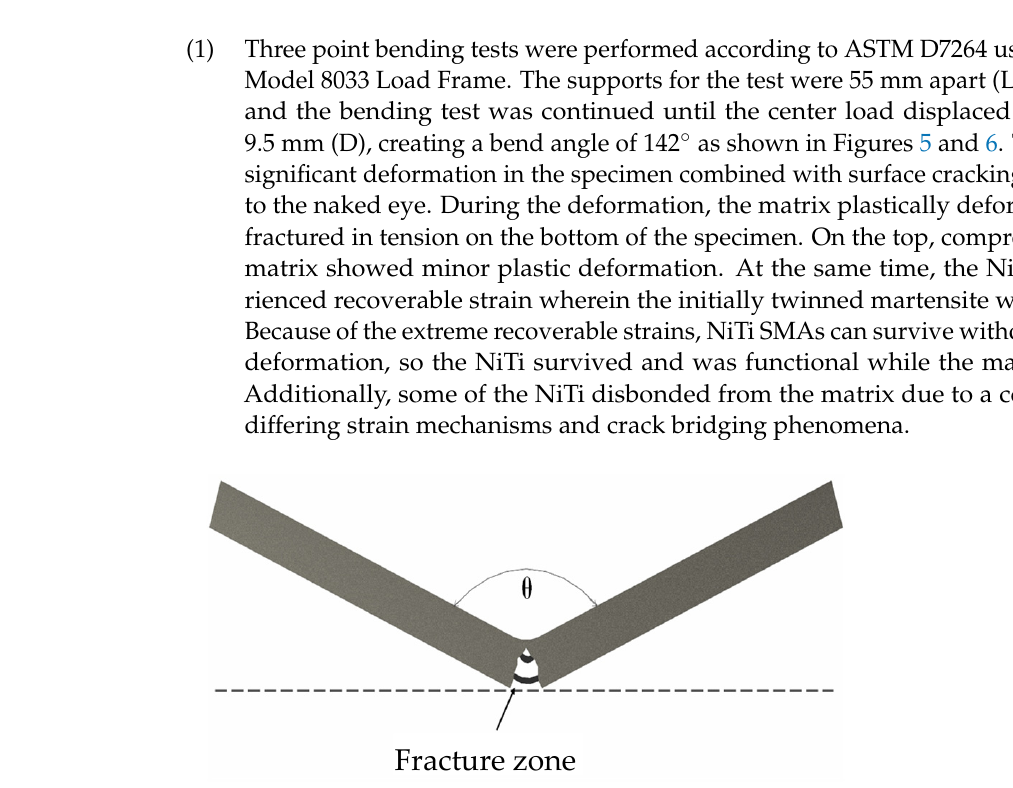
Figure 5. Deformed sample geometry.